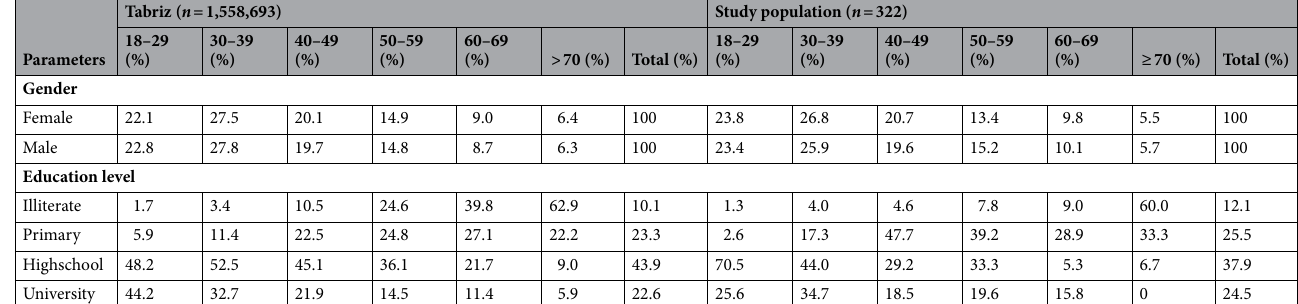
Table 1. Comparison of studied population and Tabriz population characteristics. n